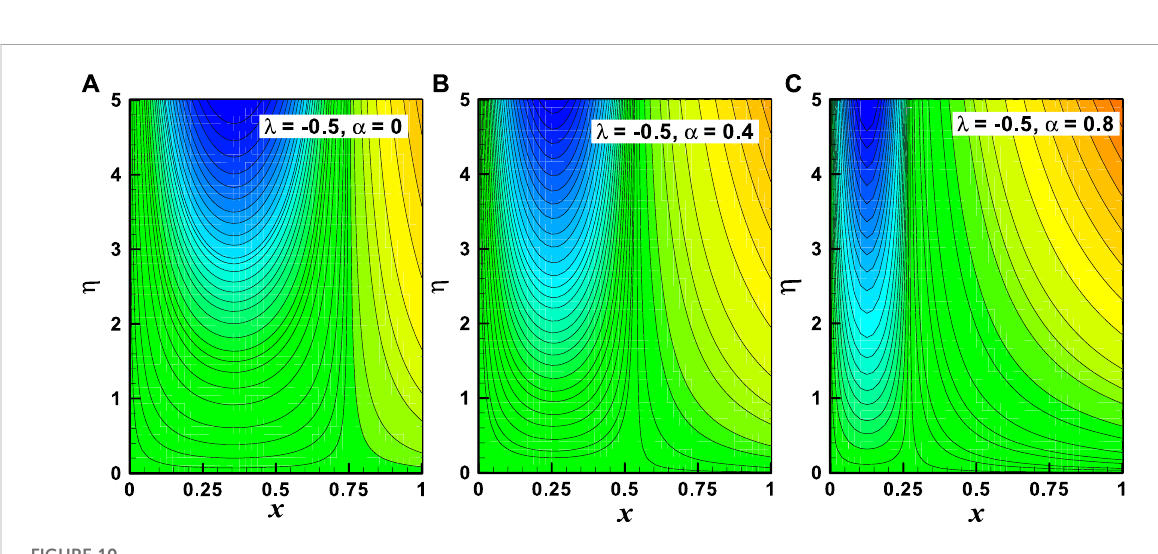
FIGURE 10 (A – C) Streamline graph of the variation of ( α ). Other parameters are m = 1 and M = 2.